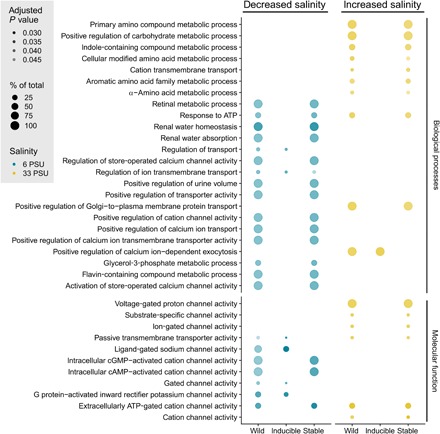
Gene Ontology terms for biological processes and molecular functions.Gene Ontology (GO) terms for biological processes and molecular functions under salinity increase (20 versus 33 PSU; yellow) and decrease (20 versus 6 PSU; blue) associated with pop-DMS are presented. The graph is split into GO terms associated with pop-DMS from natural stickleback populations across a salinity cline (wild) and their experimental inducibility (inducible and stable) in a two-generation acclimation experiment. The size of the circles refers to the number of genes of this term in the groups (in %), and the transparency refers to the false discovery rate–corrected P value (darker circles refer to a lower adjusted P value). This subset is filtered for GO terms including the following keywords: “channel,” “transport,” “water,” “chloride,” “potassium,” “homeostasis,” “ion-dependent,” “urine,” “ATP” (adenosine 5′-triphosphate), and “metabolic”; see fig. S2 for the full figure. cGMP, guanosine 3′,5′-monophosphate; cAMP, adenosine 3′,5′-monophosphate; G protein, heterotrimeric GTP-binding protein.